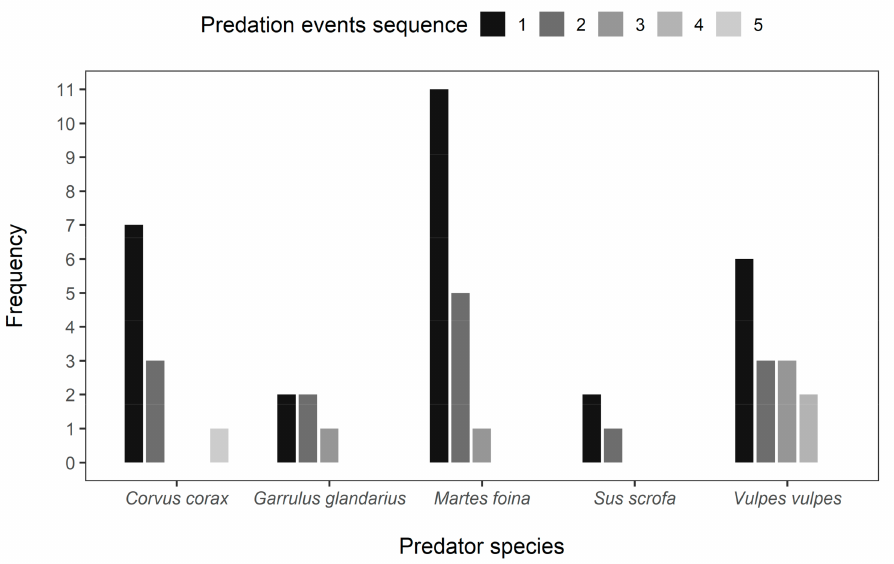
Figure 4. Predation events sequence recorded at artificial nests in both study areas together. Only predator records during predation events are presented (not predation attempts or individuals passing